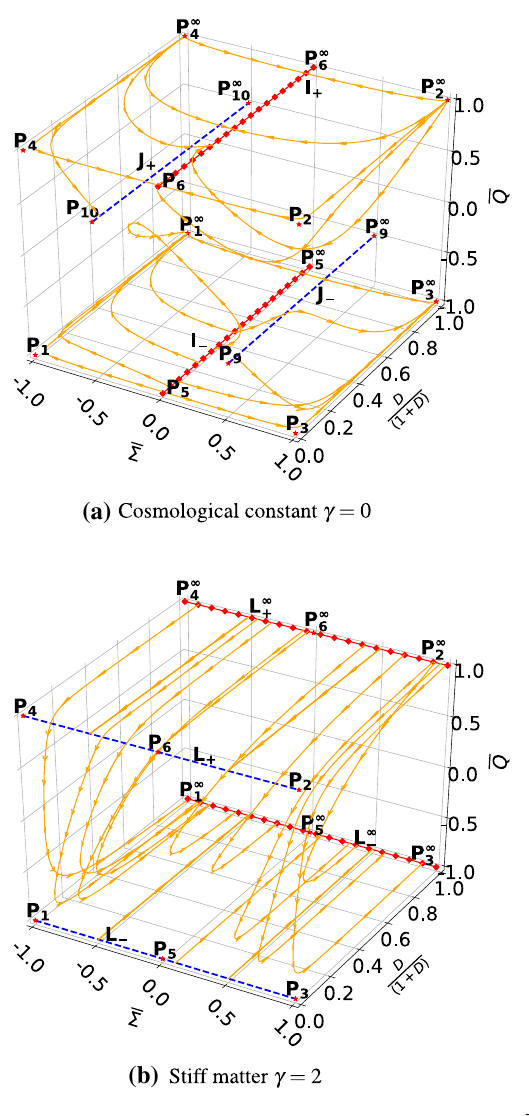
Fig. 9 Dynamics of the averaged system (127) at the invariant set ¯ (cid:8) = 0 for γ = 0 and2,representedinthecompactspace ( ¯ Σ, D /( 1 + D ), ¯ Q )